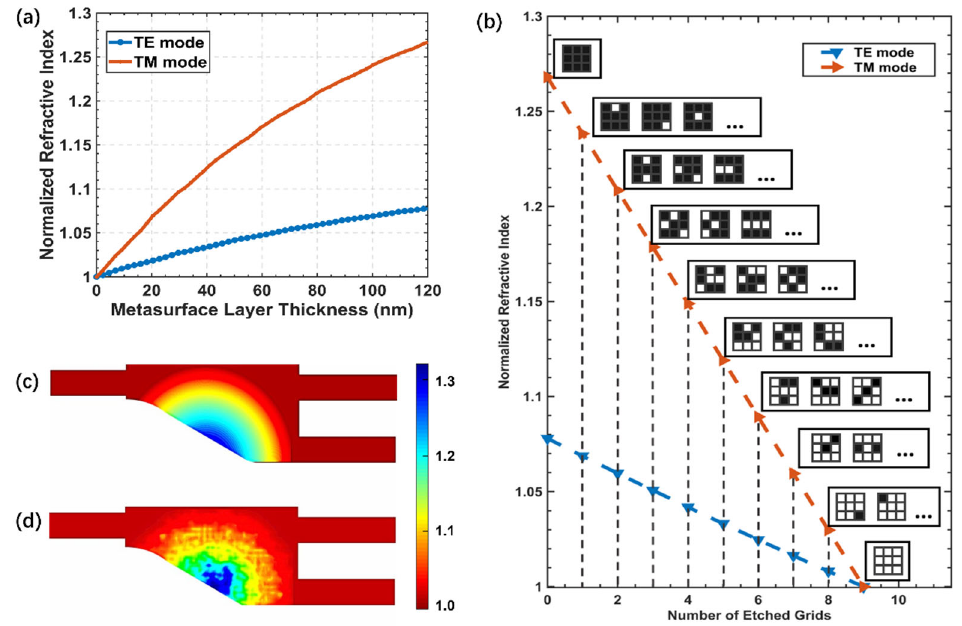
Figure 2. ( a ) The normalized effective refractive indices for the TE and TM mode as a function of the thickness of the metasurface layer. ( b ) Relationship between the number of etched grids and the normalized effective refractive indices for the TE and TM mode, thereby matching the typical cell structures of each density mode. ( c ) Index profile of the TM mode at the initial time and ( d ) after